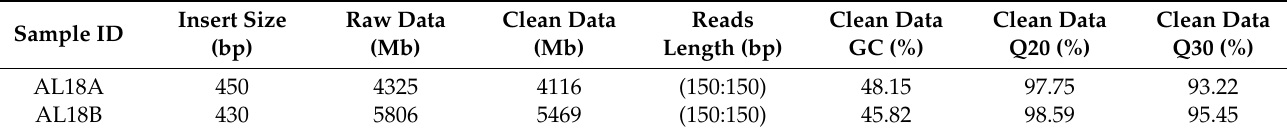
Table 1. Illumina PE sequencing data statistics of AL18A and AL18B.